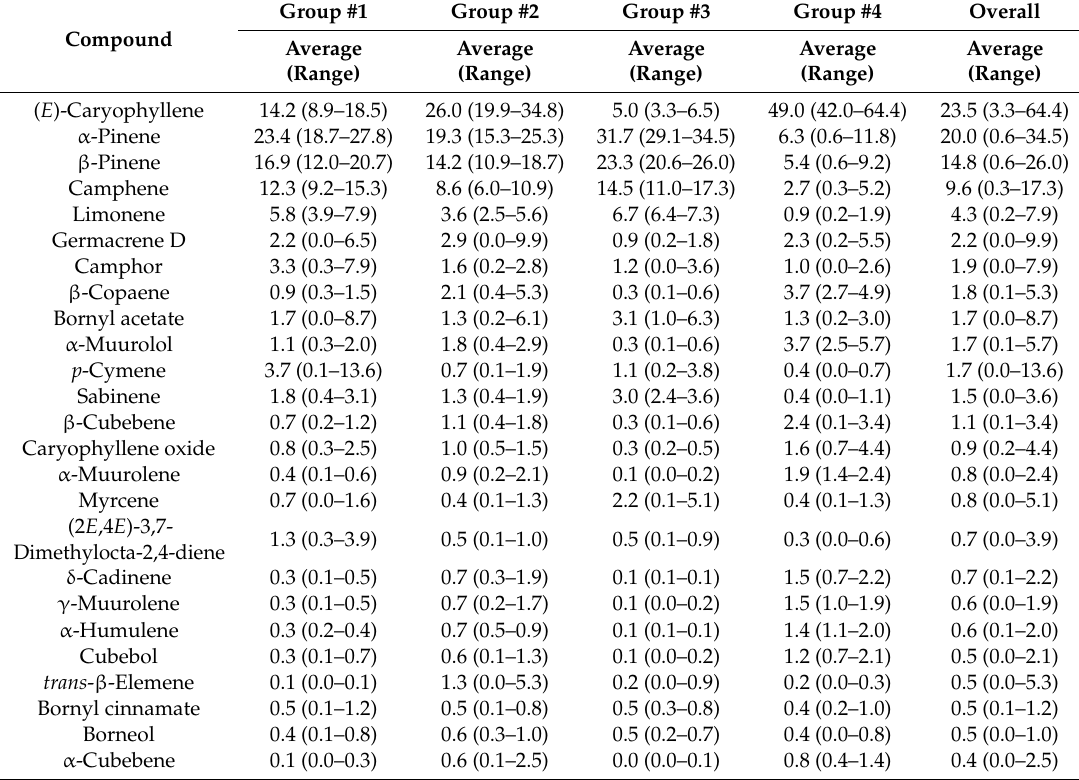
Table 2. Percentage compositions of the major components in Liquidambar formosana oleoresin essential oils.